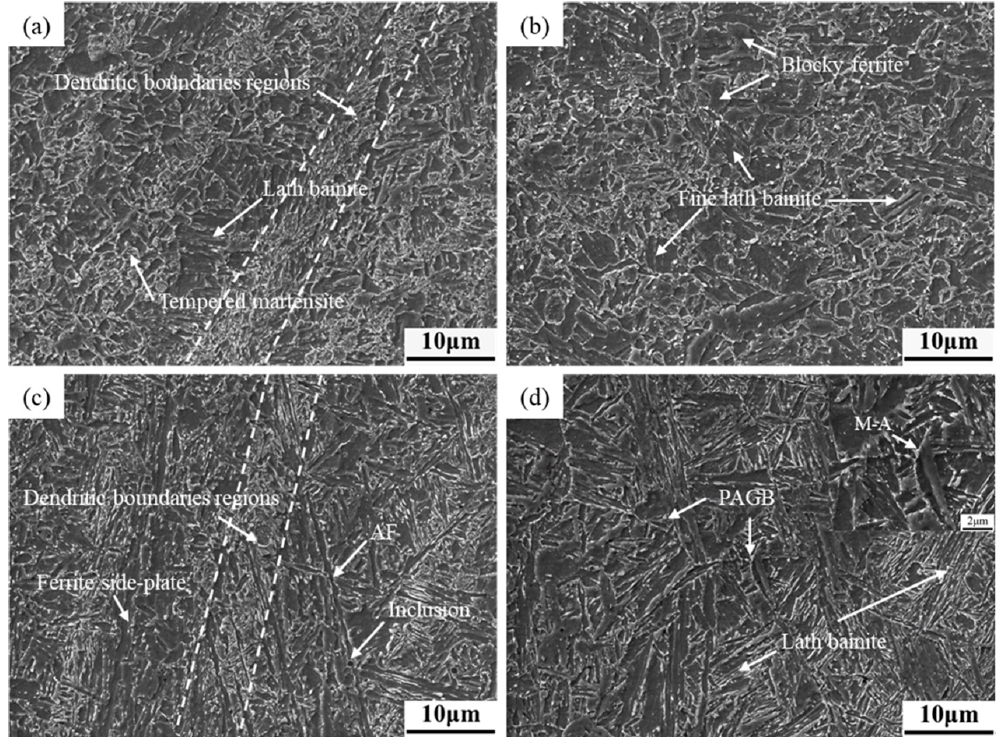
Figure 5. SEM micrographs in the columnar grain zone and the reheated zone of weld metal: ( a ) Columnar grain zone of TIG; ( b ) Reheated zone of TIG; ( c ) Columnar grain zone of SAW; ( d ) Reheated zone of